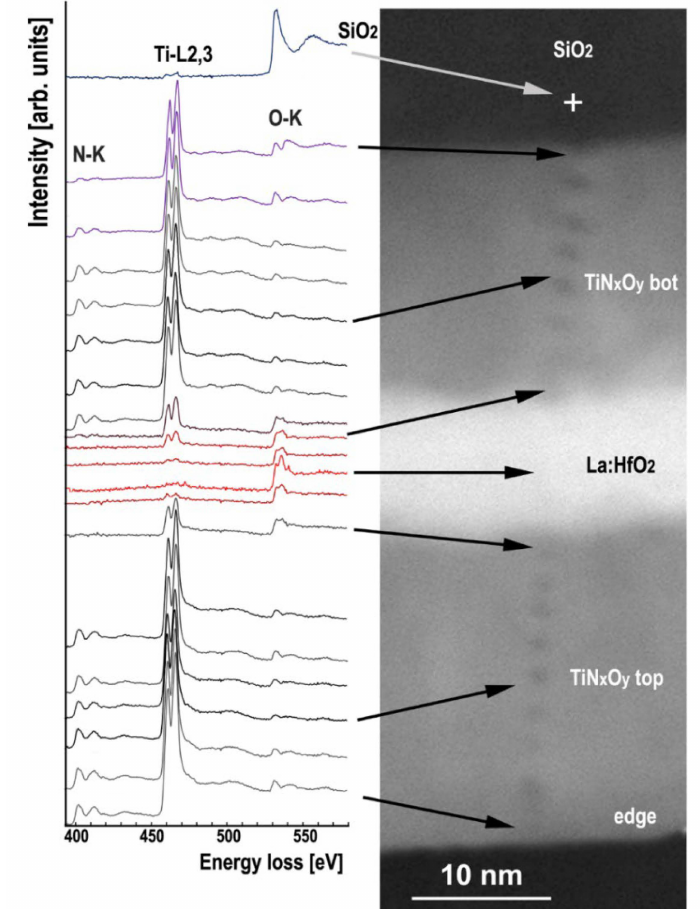
Figure 4. Set of EELS spectra in the range of 390–580 eV to show together the N-K (401 eV), Ti-L 2,3 (456 eV) and O-K (532 eV) edges obtained across the SiO 2 —TiN x O y bot—La:HfO 2 —TiN x O y top interfaces with positions indicated by arrows in the corresponding HAADF STEM image; (spectra are shifted vertically for more